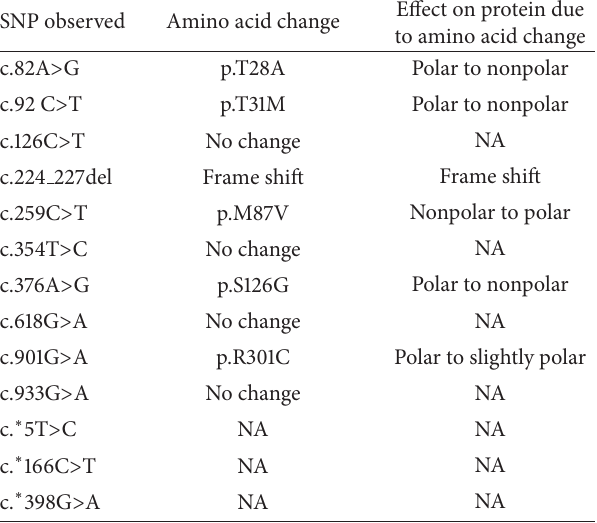
Table 2: Mutations observed in MC1R of Peruvian